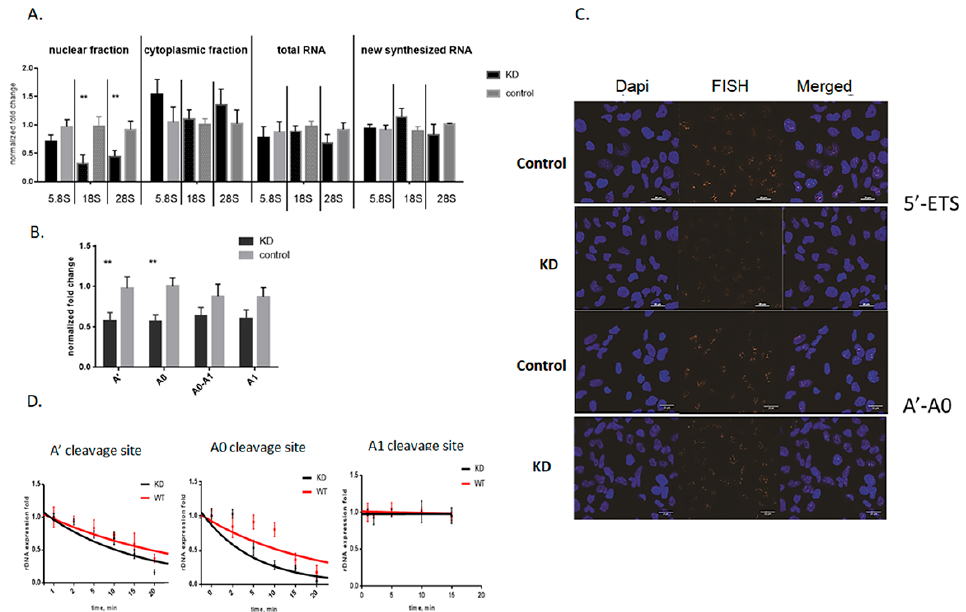
Figure 2. Changes in pre ‐ rRNA processing after 4 days of Mettl3 KD. ( A ) RT ‐ qPCR analysis of the mature 18S, 28S, and 5.8S rRNA in the nuclear and cytoplasmic fraction, total RNA, and nascent RNA in control and Mettl3 KD cells. Gapdh mRNA was used as a control for cytoplasmic fraction and total RNA, u2 (for the nuclear fraction) (* p < 0.05, ** p < 0.01). ( B ) Analysis of pre ‐ rRNA cleavage efficacy by RT ‐ qPCR at A’, A0 cleavage sites (primers were designed around cleavage site), and quantification of the A0 ‐ A1 RNA spacer in the total RNA (* p < 0.05, ** p < 0.01). ( C ) FISH analysis of 5 ′‐ ETS of 47S pre ‐ rRNA, A’ ‐ A0 RNA spacer in control, and Mettl3 KD cells. DNA was stained with DAPI, and rRNA with Cy3 ‐ labeled probes (Table S3). ( D ) Estimation of the pre ‐ RNA processing rate at A0 and A’ cleavage sites in control and Mettl3 KD cells by actinomycin D assay.